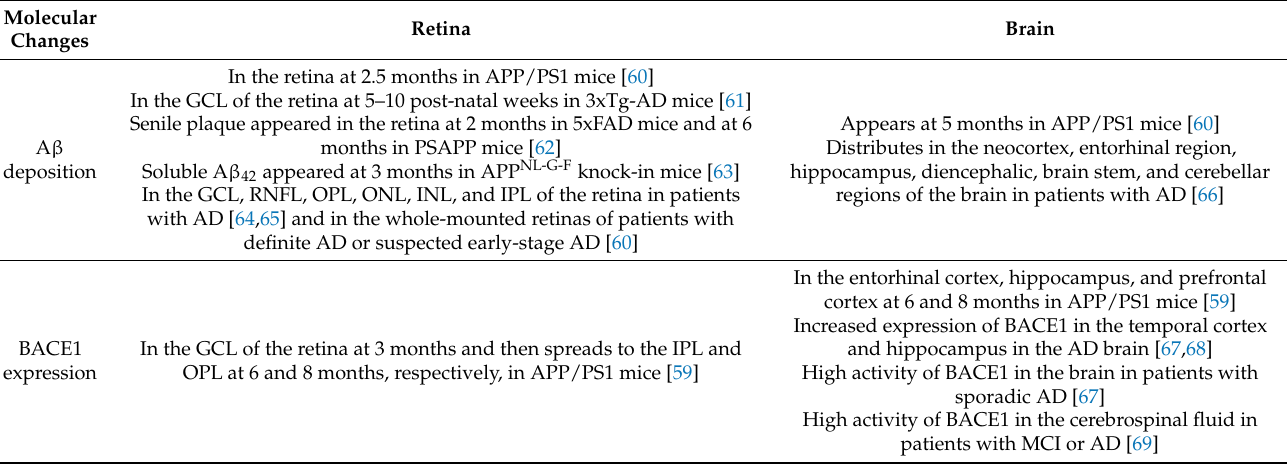
Table 1. Sequential occurrence of amyloid-beta deposition and BACE1 appearance in the retina and the brain in Alzheimer’s